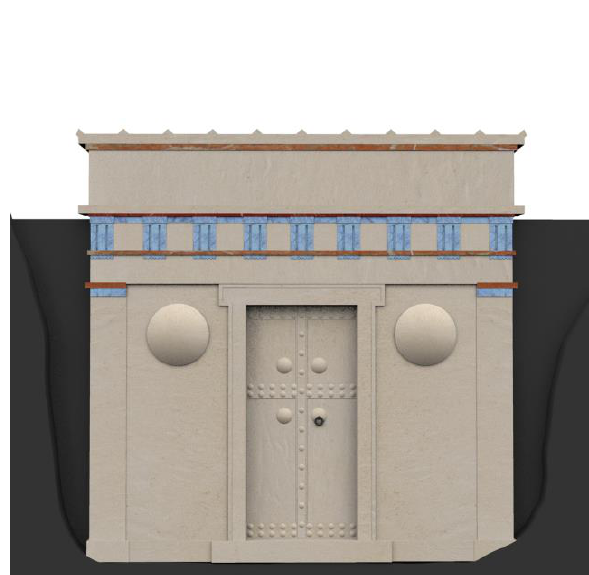
Figure 27. The Tomb of Alexander IV at Verghina. 3D model of the current state.